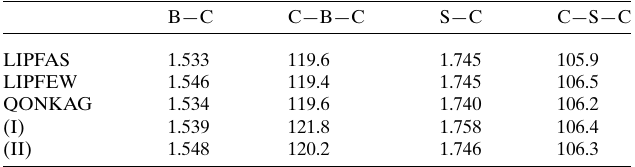
Table 1 Comparison of B—C and S—S bond lengths and C—B—C and C—S—C bond angles (A˚ , (cid:2) ).